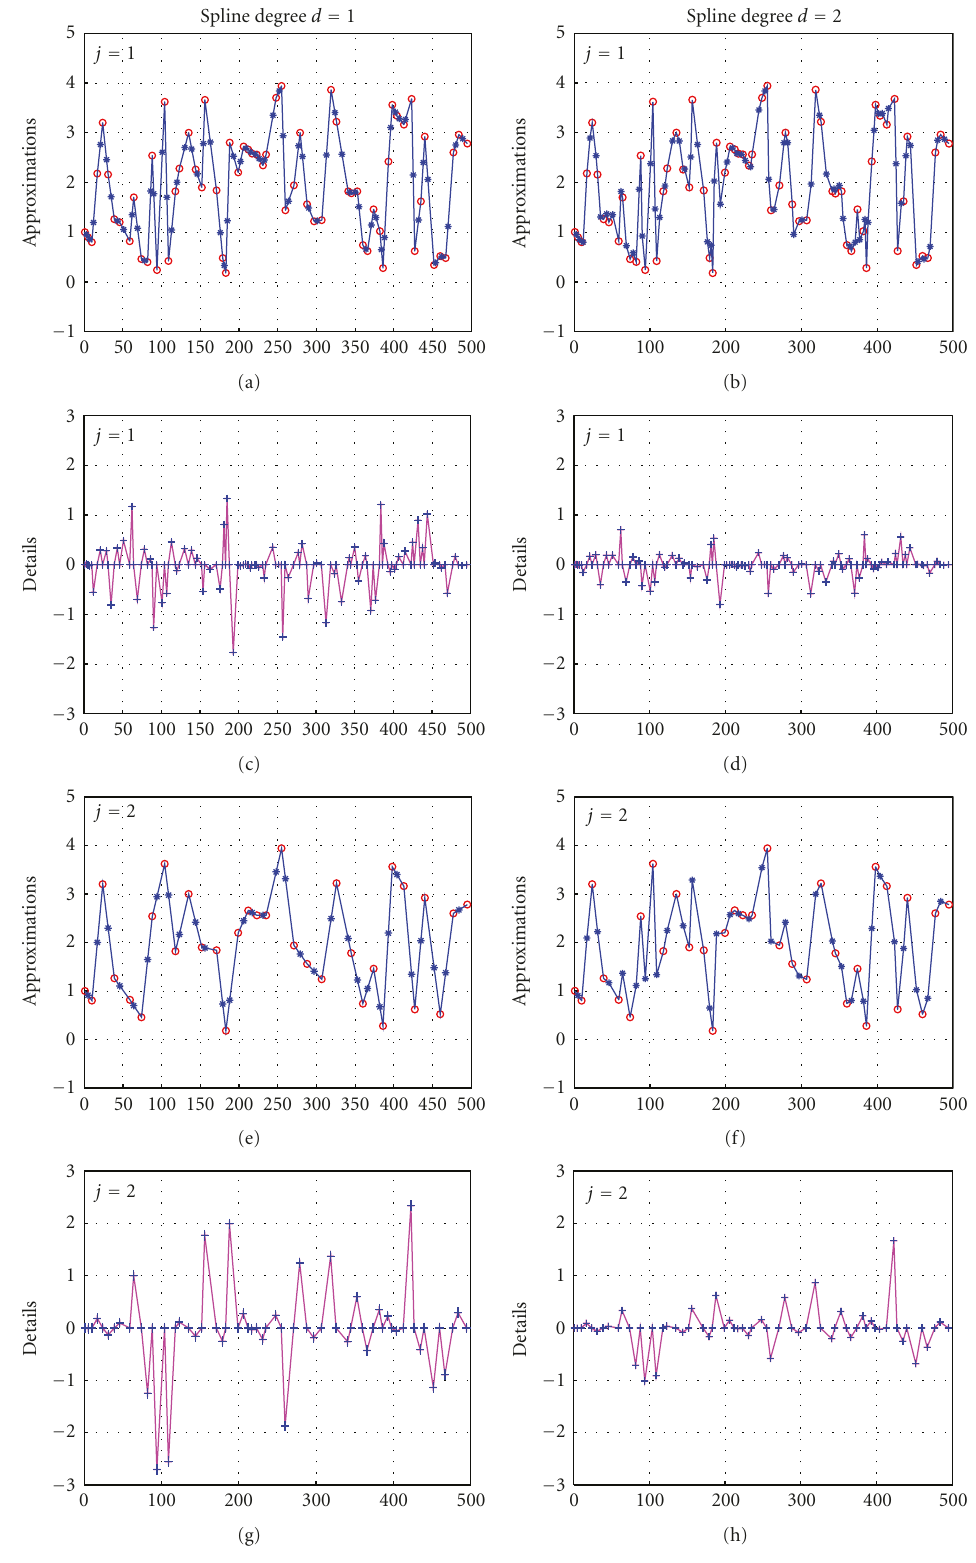
Figure 10: Orthogonal decomposition; “ ∗ ” approximated signals, “o” irregularly discrete samples, “+” residual signals at respective resolution levels j = 1,2 from linear and quadratic orthonormal piecewise polynomial scaling and wavelet